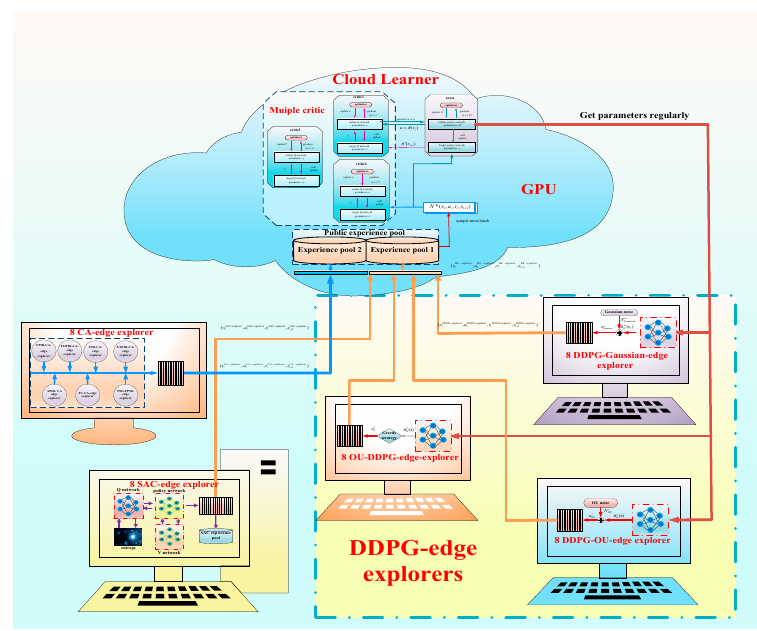
Figure 3. Distributed training framework of ECMTD-DDPG.